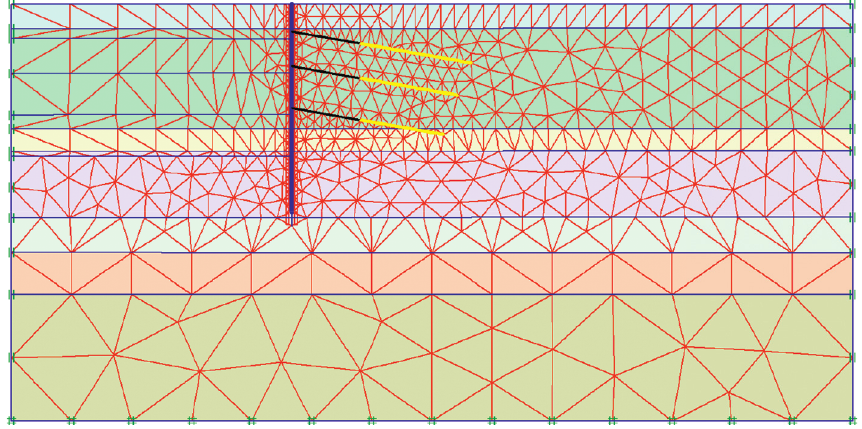
Figure 7: Finite element meshing.